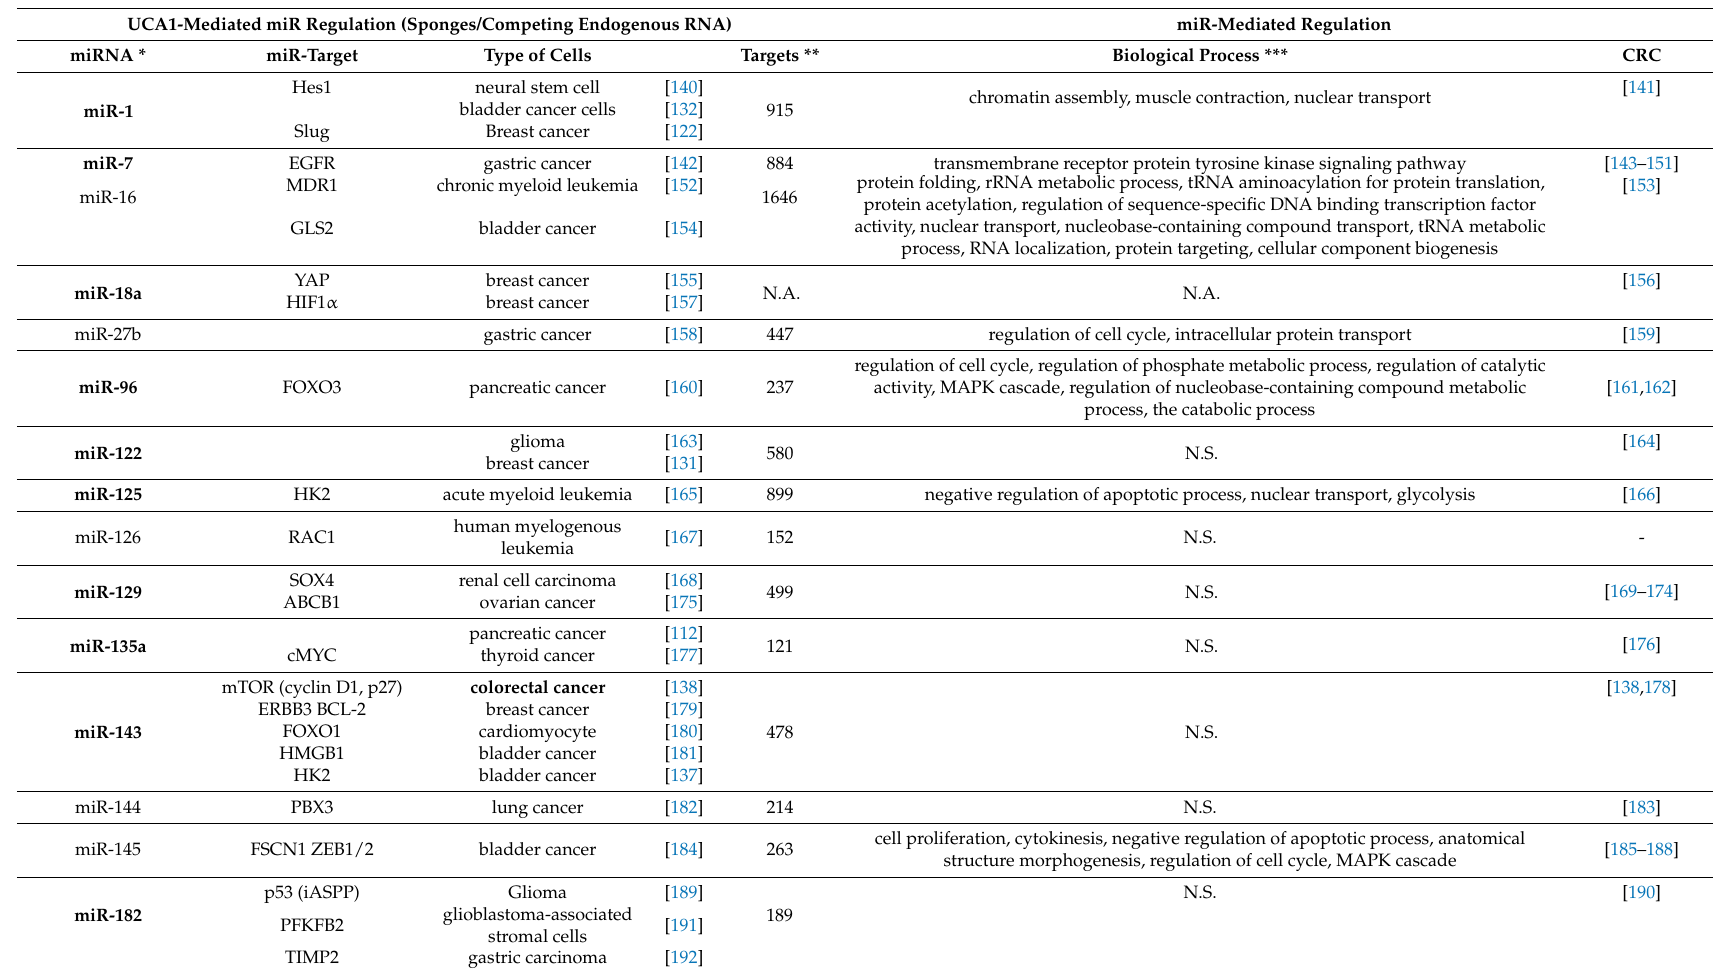
Table 4. The UCA1-mediated regulation of miRNA